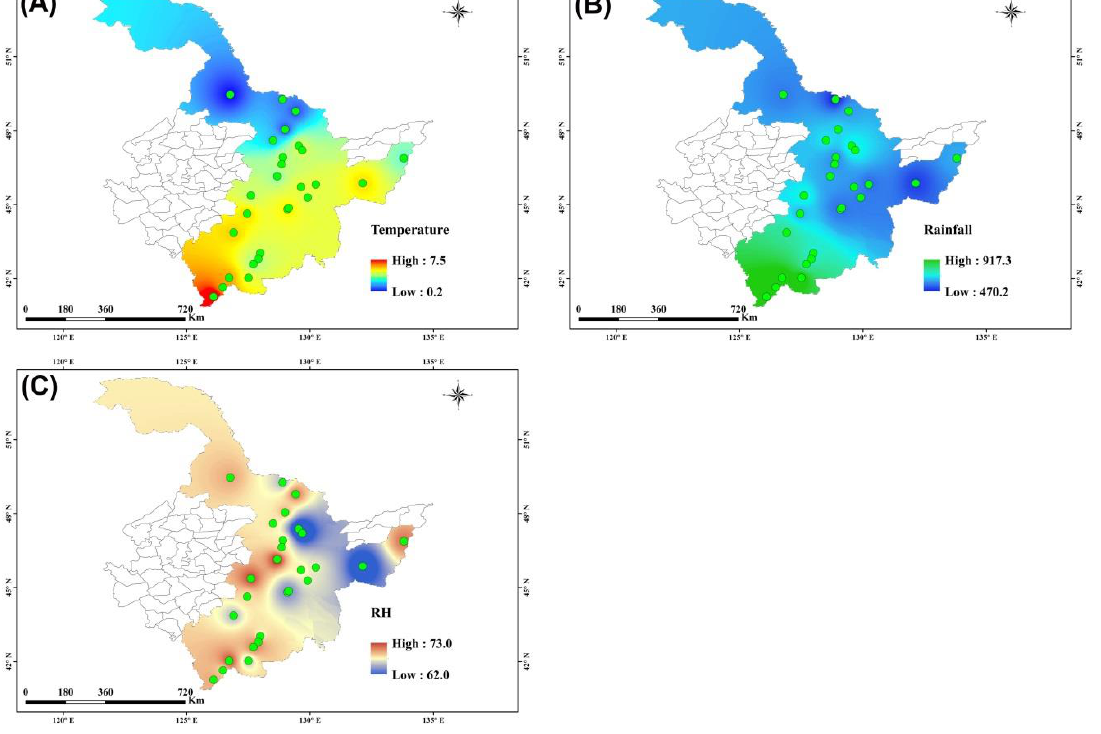
Figure 3. Interpolated mapping of geographical distributions of climatic factors in forests harboring Eleutherococcus senticosus populations in Northeast China. ( A ) Geographical distribution of temperature ( ◦ C); ( B ) geographical distribution of annual rainfall; ( C ) geographical distribution of relative humidity (RH) (%). Green dots indicate distribution of